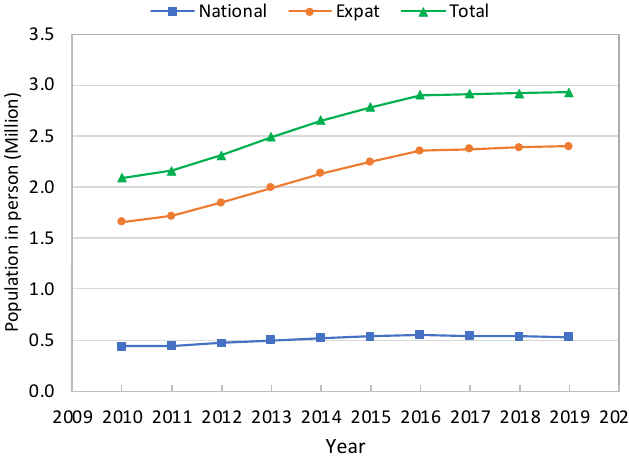
Figure 3. Abu Dhabi’s population from 2010 to 2019 (nationals and expats).